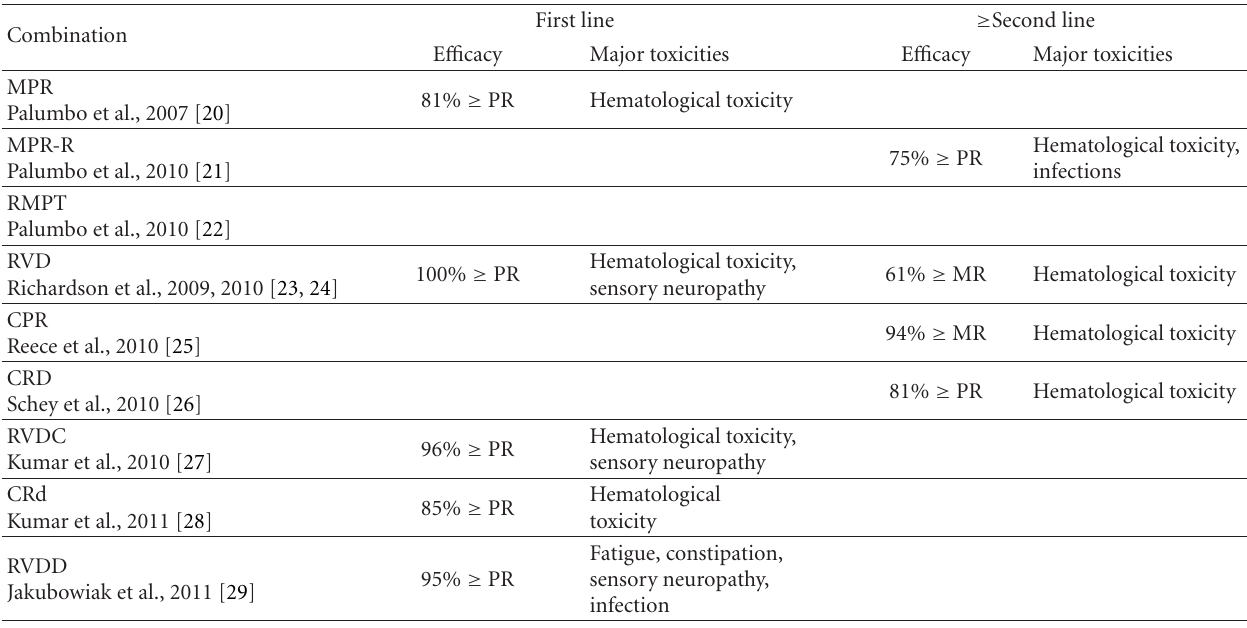
Table 8: Summary of emerging lenalidomide combination therapies in the first- and second-line treatment of multiple